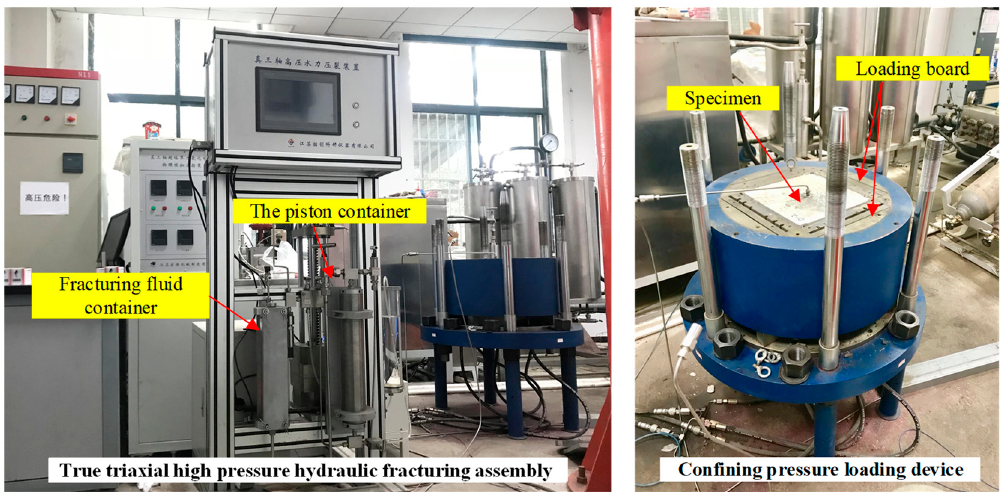
Figure 23. Schematic of the triaxial hydraulic fracturing test system used in the experiment.